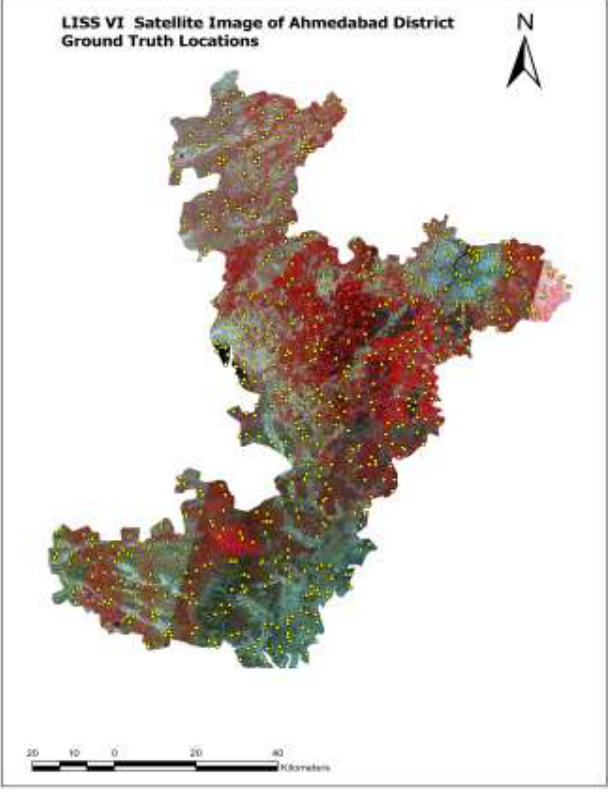
Figure 4. Distribution of Ground truth points on